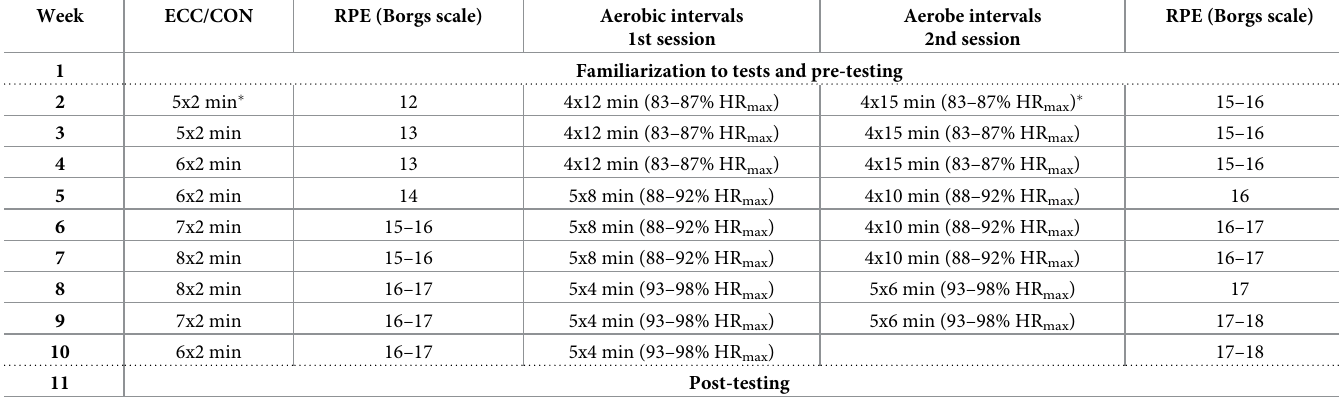
Table 1. Overview of the intervention